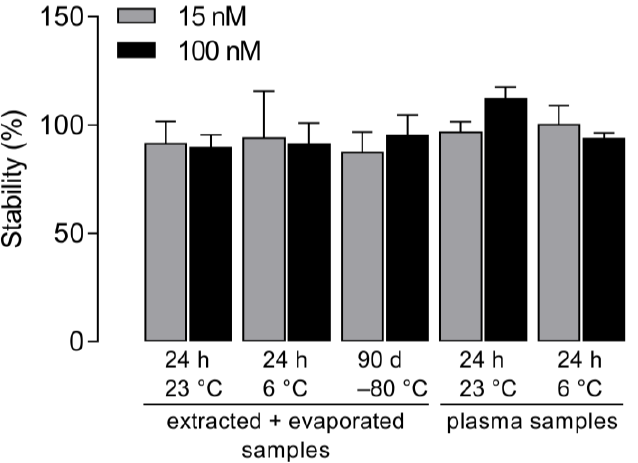
Figure 4. Stability of silmitasertib as a function of time and temperature of storage, relative to freshly extracted controls on the day of measurement (set to 100%). The ratio of the m/z values of the quantifiers m/z 223.1 (silmitasertib) and m/z 250.1 (internal standard) was determined. Shown are mean values ± SD of n = 3 independent LC–MS/MS runs.